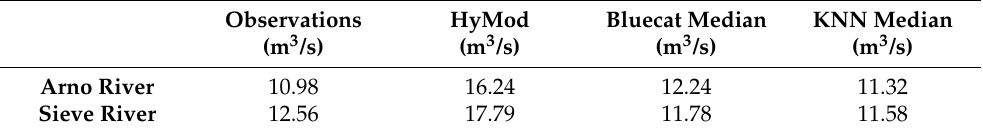
Table 1. Mean value of the time series of observations, of the HyMod simulation, and of the Bluecat Median and KNN Median.